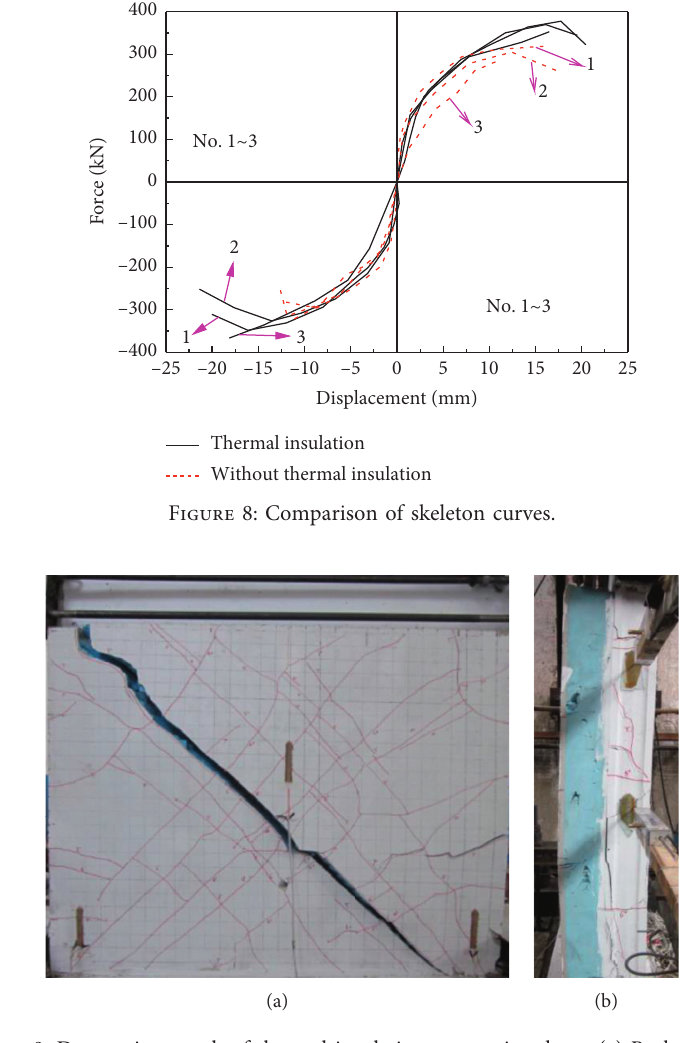
Figure 9: Destruction graph of thermal-insulation composite plates. (a) Back. (b) Side.